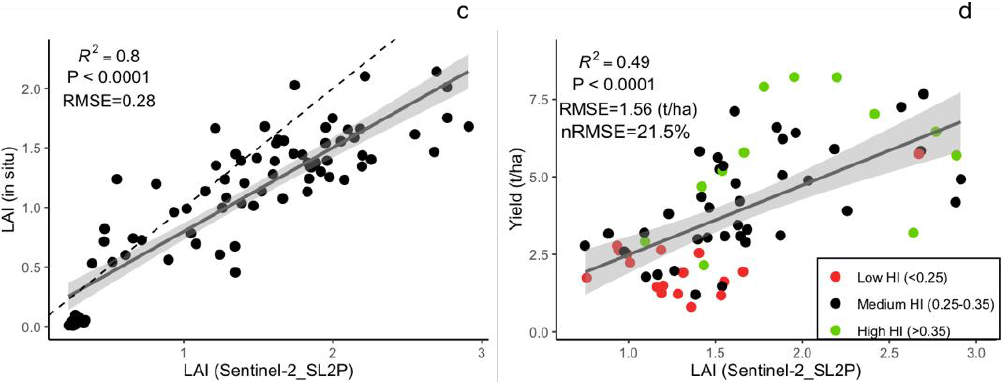
Figure 7. Linear correlation between in situ maize yield from 68 fields and ( a ) maximum PlanetScope EVI and ( b ) maximum CIgreen; ( c ) Correlation between in-situ LAI and SL2P-derived LAI; ( d ) linear regression between in situ yield and seasonal maximum SL2P-derived LAI. The colored dots indicate the harvest index (HI) category.